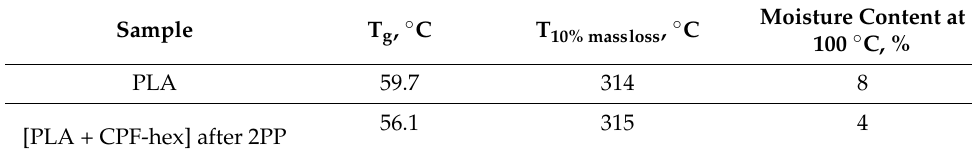
Figure 8. DSC curves of the initial methacrylate-terminated star-shaped polylactide (PLA) and the polylactide-based resin after the 2PP processing ([PLA + CPF-hex] after 2PP). Table 1. Thermal properties of the initial methacrylate-terminated star-shaped polylactide (PLA) and the polylactide-based resin after the 2PP processing ([PLA + CPF-hex] after 2PP).